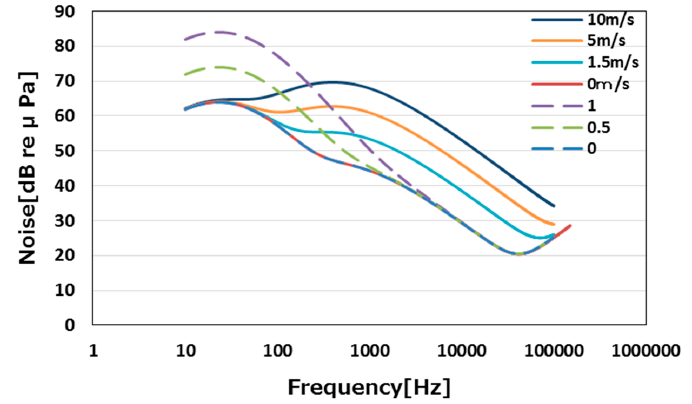
Figure 10. Influences of various noises at different frequencies.